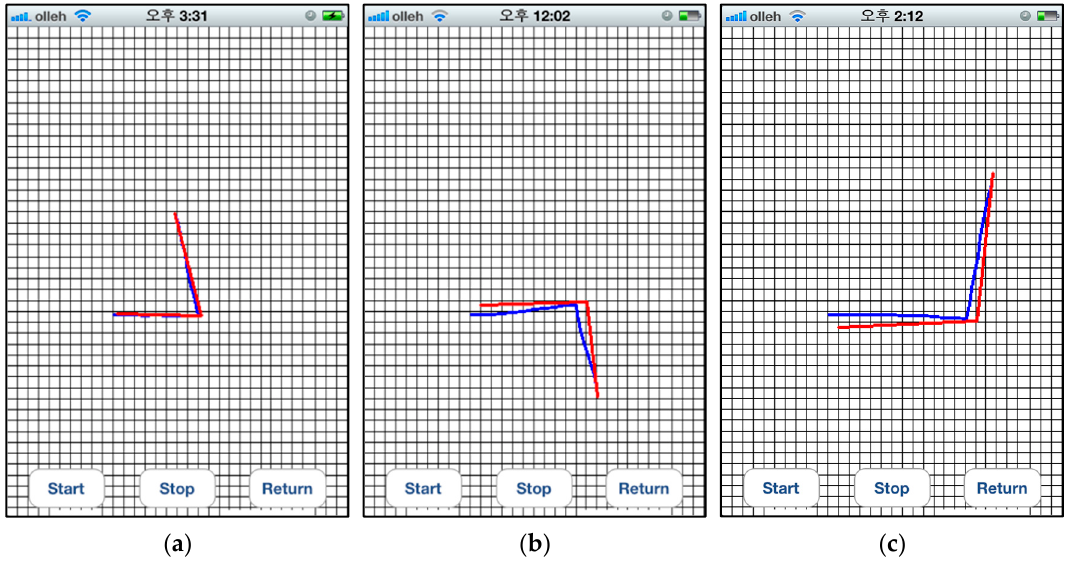
Figure 15. Estimation of users’ traces for complex movements: Routes generated by ( a ) User 1, ( b ) User 2, and ( c ) User 3, respectively.